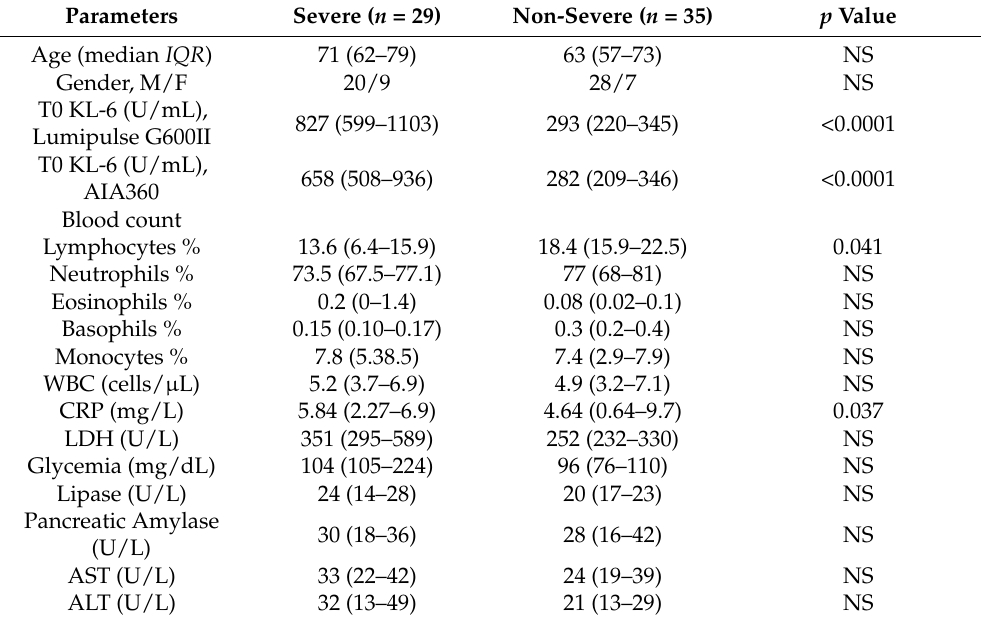
Table 1. Demographic and immunological data of COVID-19 hospitalized patients stratified accord- ing to disease severity. Abbreviation: WBC, white blood cells; NS, not significant; KL-6, Krebs von den Lungen-6. All data were expressed as median and interquartile range.